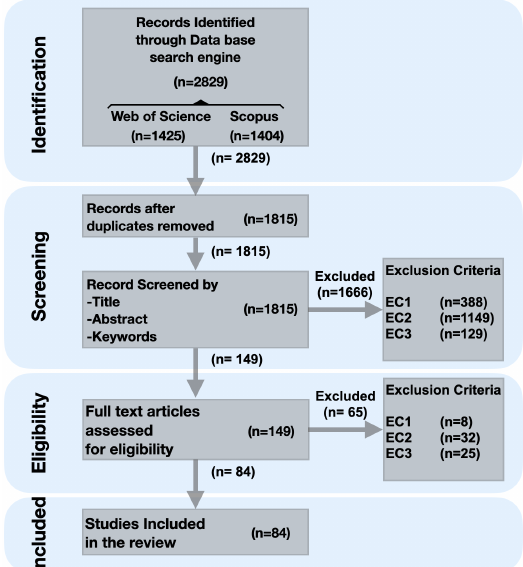
Figure 2. PRISMA flow